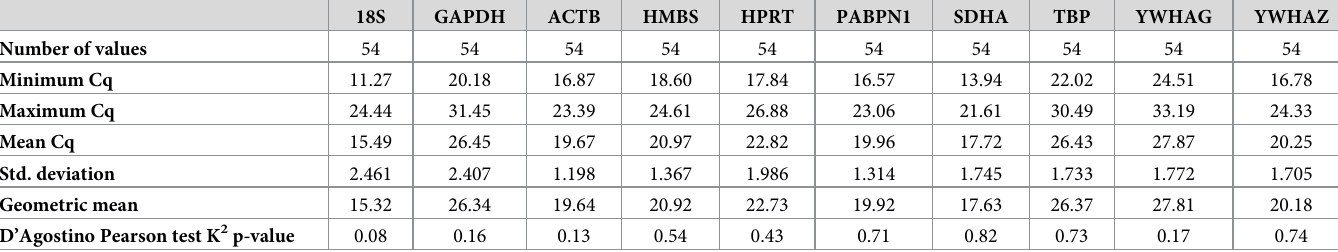
Reference gene ranking. Normfinder, qBase+, BestKeeper and comparative Δ Cq approaches were used to assess the initial stability of candidate reference genes. The candidate reference genes are ranked in Table 4 with corresponding stability values in descending order (0.23) and PABPN1 and YWHAG as second (0.36). For Normfinder, lower values have greater stability. For a 2 gene stability factor, Normfinder found HMBS and YWHAG as the best two genes to construct a normalisation factor of 0.187. The qBase+ algorithm ranked ACTB , Table 2. Descriptive statistics of reference gene